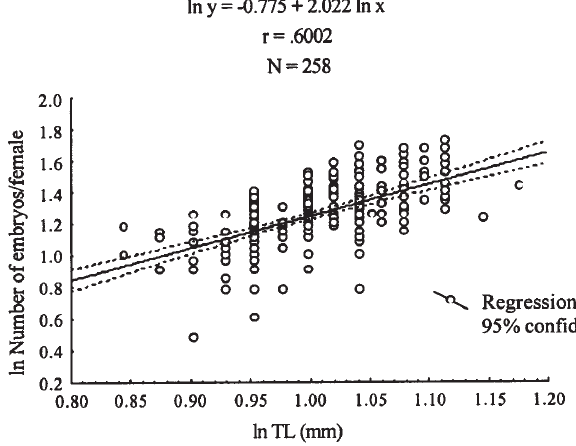
F IG . 6. – Relationship between the number of embryos per female of Neomysis americana and female